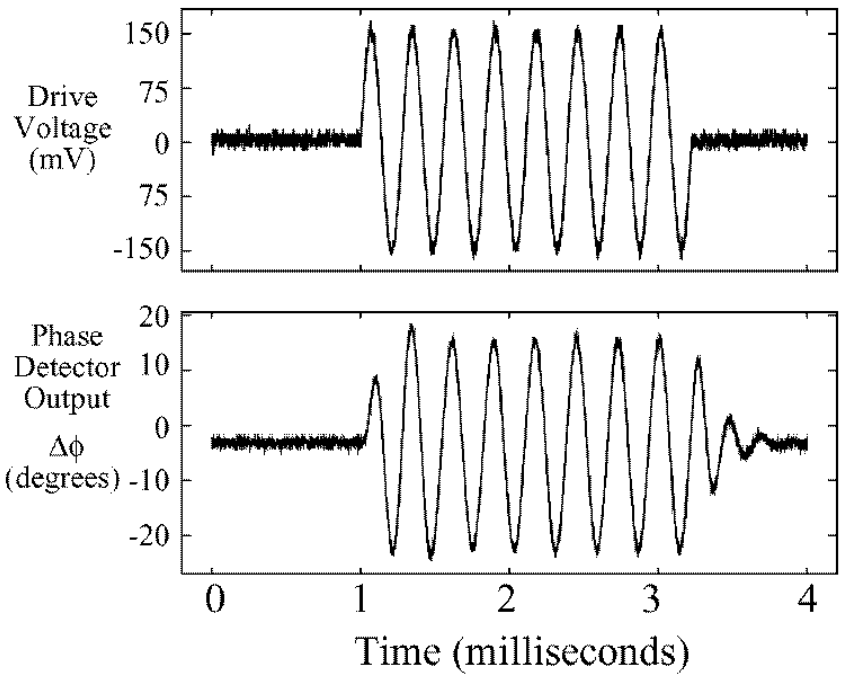
FIG. 13. Response of phase control loop to eight cycles of 3.6 kHz from AFG.